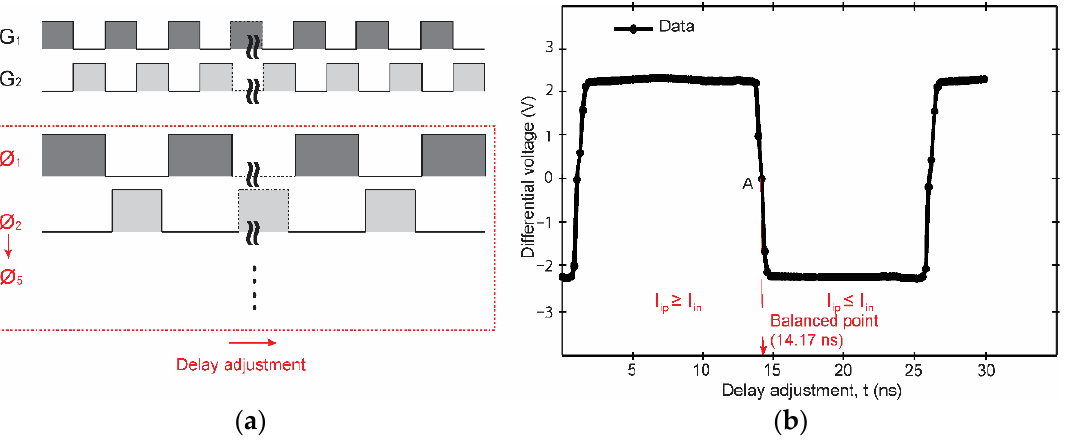
Figure 12. Gate clock timing calibration. ( a ) Timing configuration for the calibration. ( b ) Result of the timing calibration curve that determines the delay (balanced point) by observing the minimum differential voltage proportional to the current difference at the circuit input.